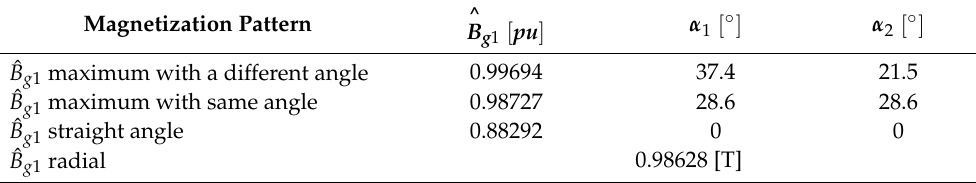
Table 7. Peak fundamental flux density result and corresponding tilt